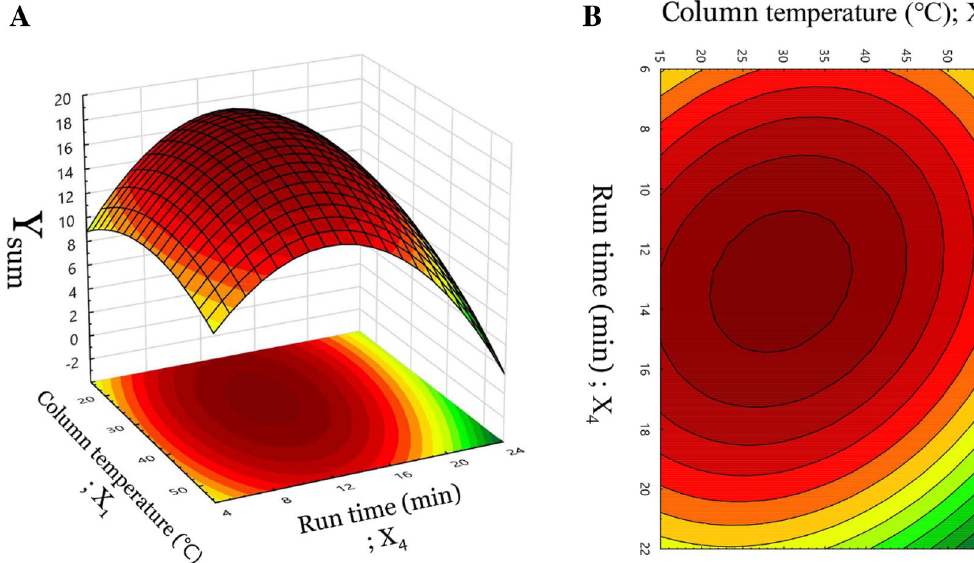
Figure 5. 3D response surface plot ( A ) and 2D contour plot ( B ) depicting the interaction of two critical method parameters (CMPs) on the Y sum .